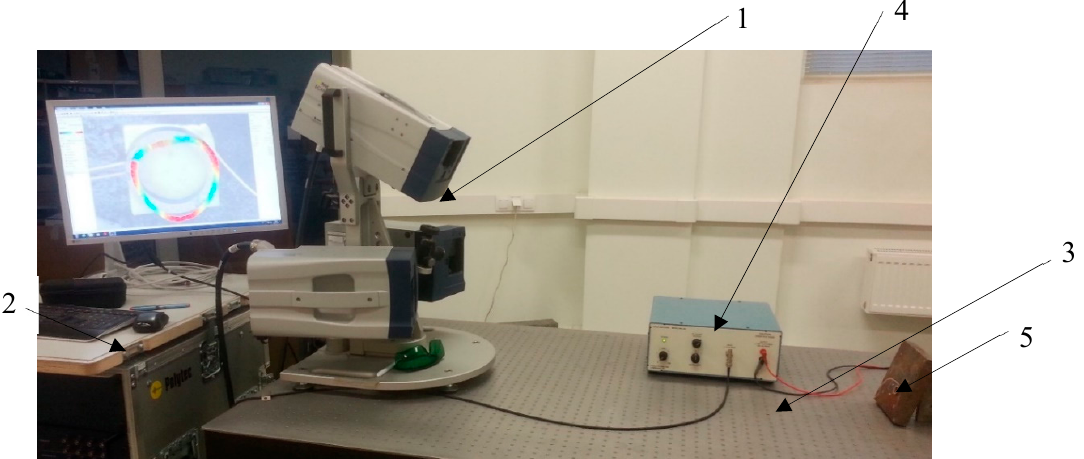
Figure 9. Experimental setup with Polytec Laser Doppler Scanner. 1—PSV-500 3D scanning Head of the vibrometer; 2—PSV-500 3D scanning vibrometer and PC; 3—optical table; 4—amplifier EPA-100 (PiezoSystems Inc., Hopedale, MA, USA); 5—Steel plate with the mounted piezoelectric ring. The piezoelectric ring is mounted on a metal plate and fixed with double-sided adhesive tape.